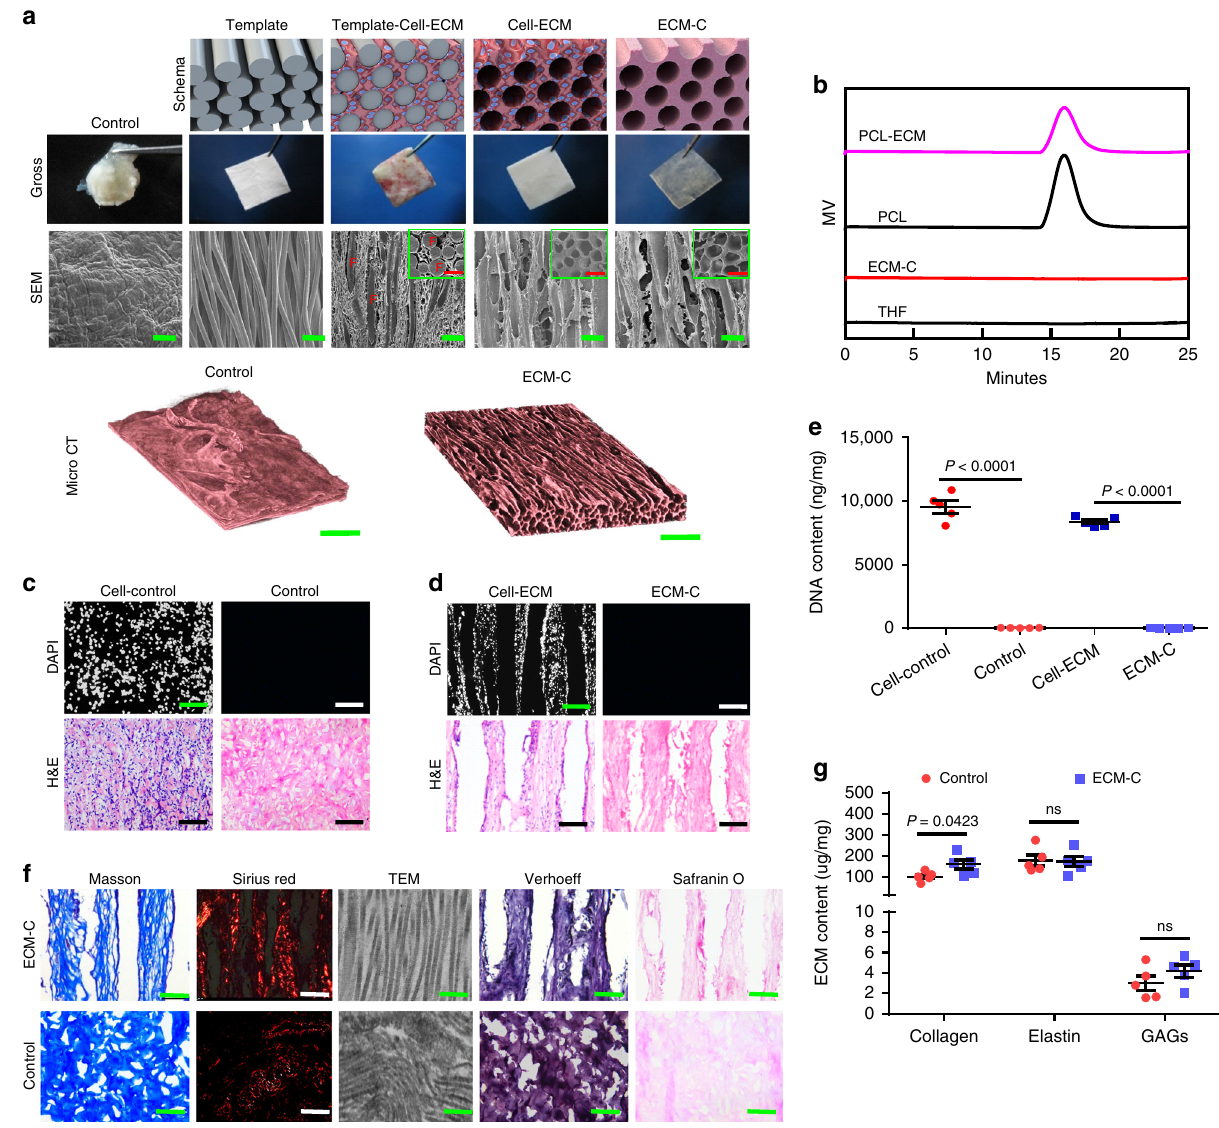
Fig. 2 Fabrication and characterisation of ECM-C and control scaffolds. a The schematic diagram, gross morphology (optical imaging) and the microstructure (SEM) of PCL fi bre template, template-cell-ECM, cell-ECM, ECM-C and control group during the preparation process; micro-computed tomography (microCT) showing three-dimensional macro and micro structure of ECM-C and control scaffolds. Inset: SEM examination of the transverse sections. F indicates the PCL micro fi ber. b Gel permeation chromatography analysis showing complete removal of PCL. c , d DAPI and H&E staining of undecellularized control, control scaffolds, cell-ECM composite, and ECM-C scaffolds. e DNA contents of cell-ECM composite, ECM-C, undecellularized control and control group, the samples were treated with 1% SDS containing DNase and RNase ( n = 5). f Masson trichrome staining, Sirius red staining, TEM, Verhoeff and safranin O staining showed the ECM components including collagen, elastin and glycosaminoglycan in ECM-C and control scaffolds. g Comparison of ECM contents between ECM-C and control group including collagen, elastin and glycosaminoglycans ( n = 5). Bar heights and error bars represent means ± s.e.m. ( t -test). Statistical analysis (ns = no signi fi cance). Scale bars: a , SEM images: 300 μ m; Micro CT image: 500 μ m; c , d , 100 μ m; f , histology panels: 100 µ m; TEM image: 200